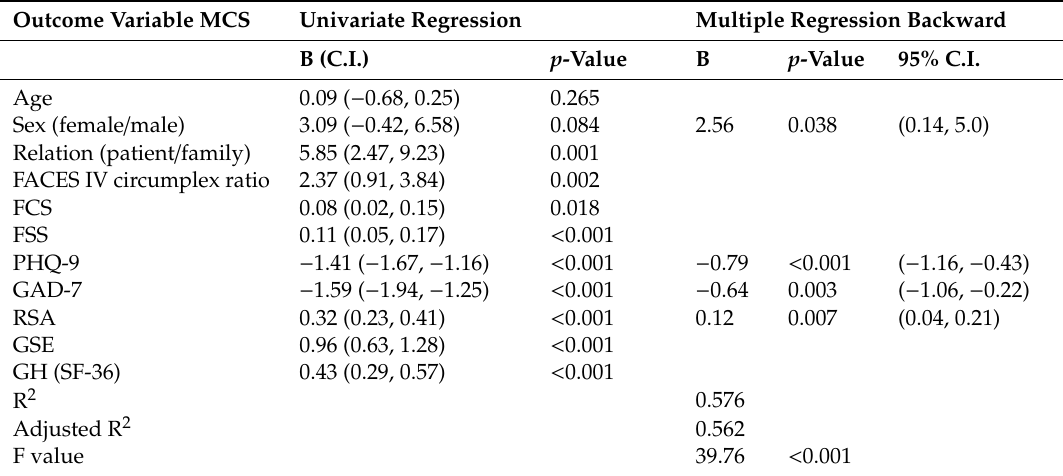
Table 4. Results of the regression analyses and results of the final multiple regression